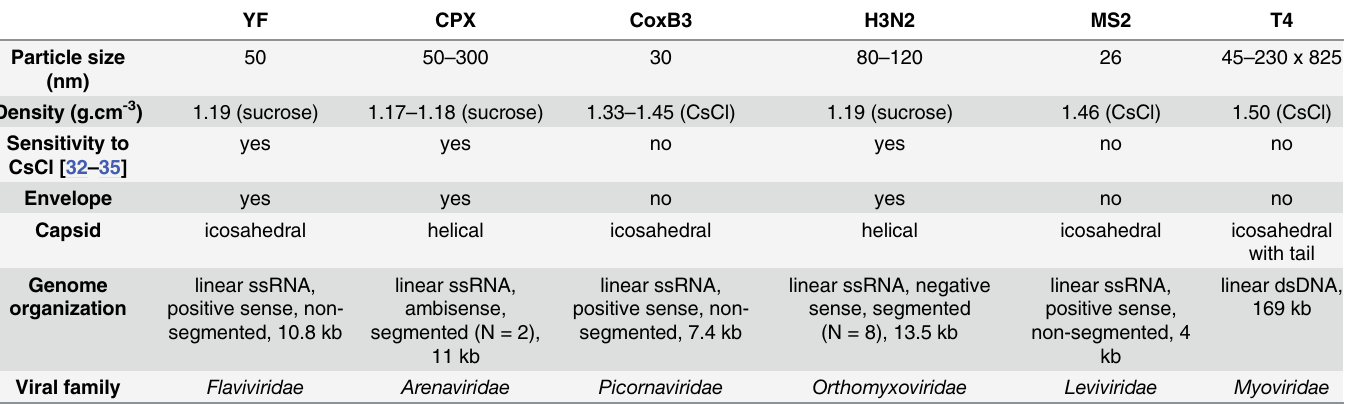
Table 1. Characteristics of reference